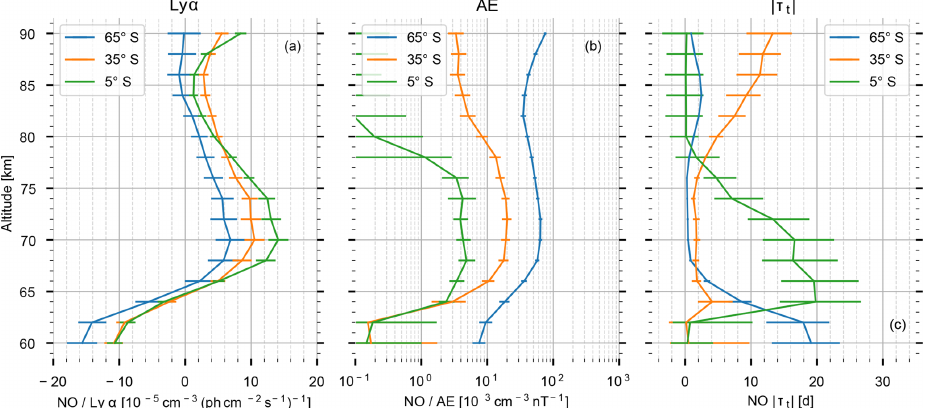
Figure 6. Coefficient profiles of the solar index parameter (Lyman- α , left, a ), the geomagnetic index parameter (AE, middle, b ), and the amplitude of the annual variation of the NO lifetime (right, c ) at 5 (green), 35 (orange), and 65 ◦ S (blue). The solid line indicates the median, and the error bars indicate the 95% confidence